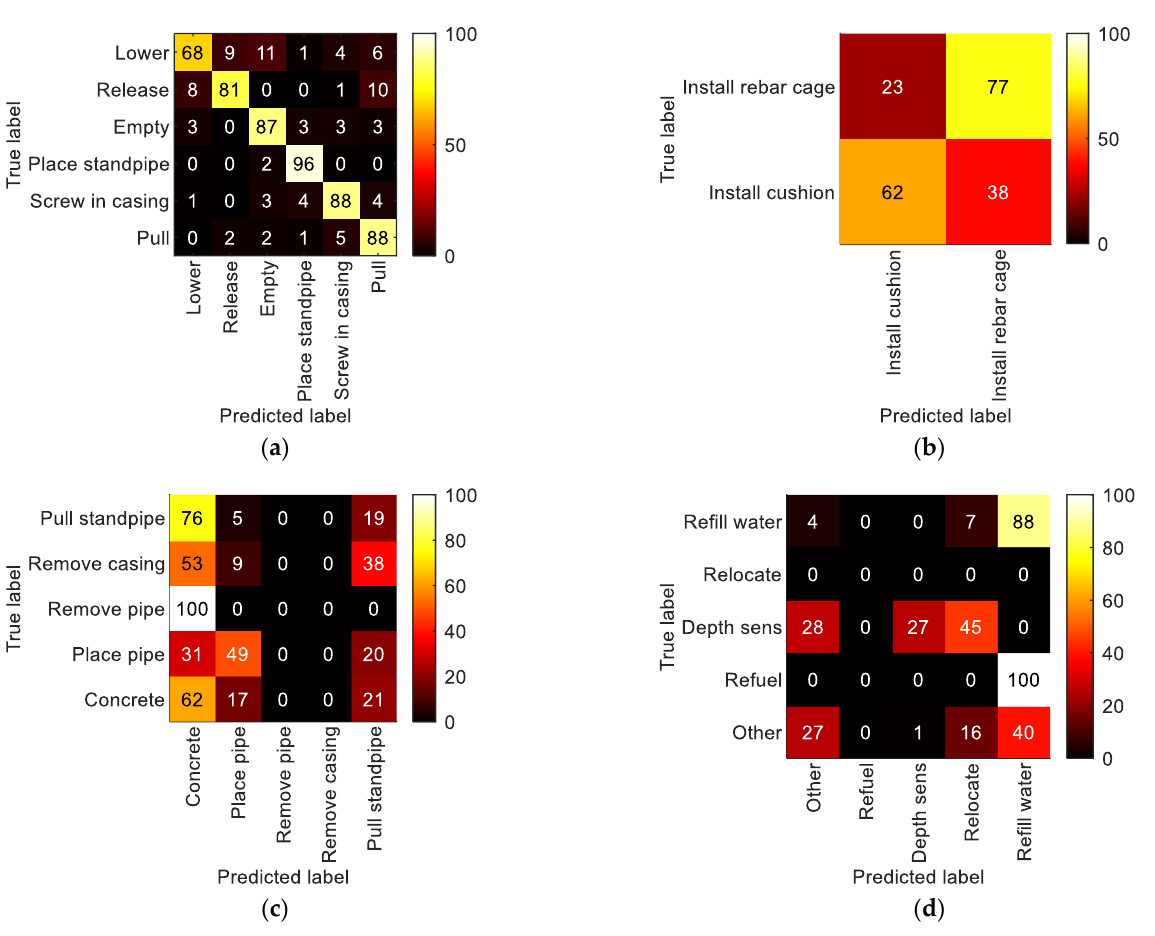
Figure A6. LoD3 confusion matrix for the DeepConvLSTM: ( a ) drill, ( b ) reinforce; ( c ) concrete; and ( d ) secondary processes.